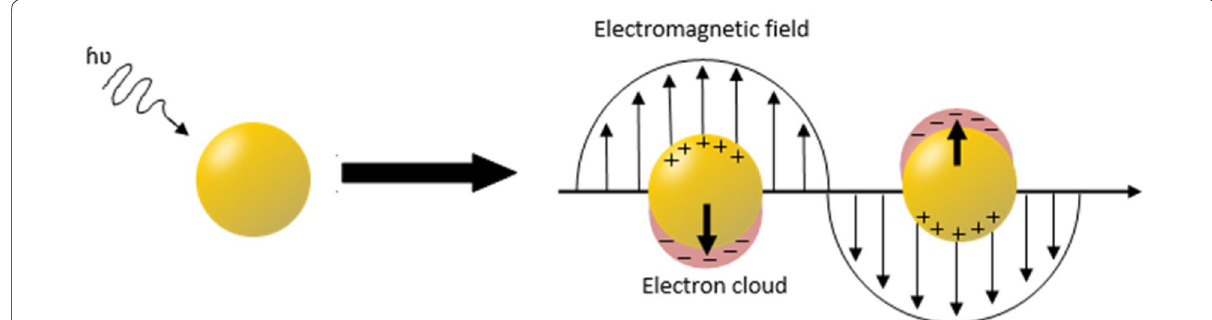
Fig. 2 Schematic representation of the conduction electrons oscillating across the gold nanoparticle in the electromagnetic field of incident